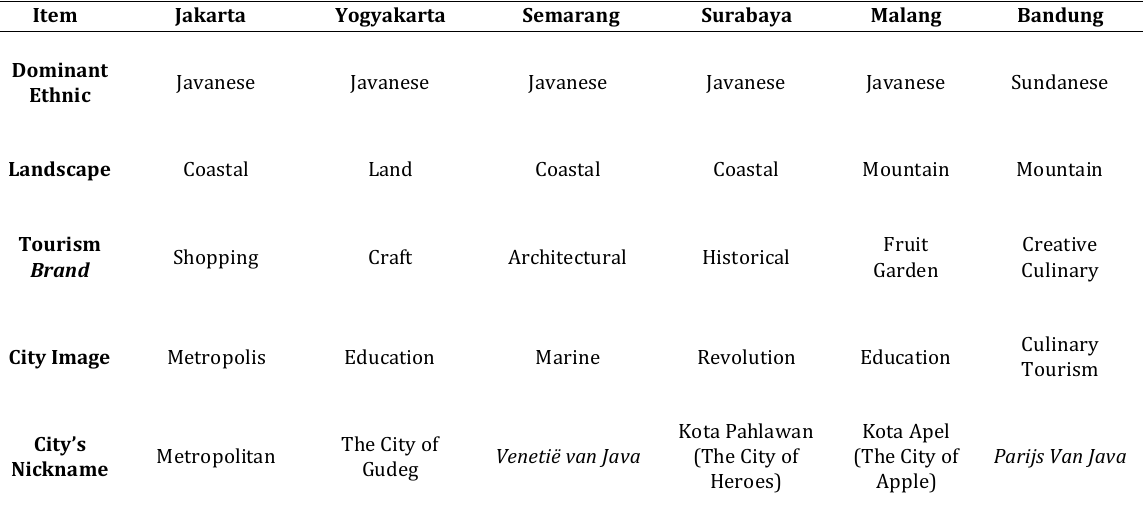
Table 1 Comparison of Tourist Destination for Cities in